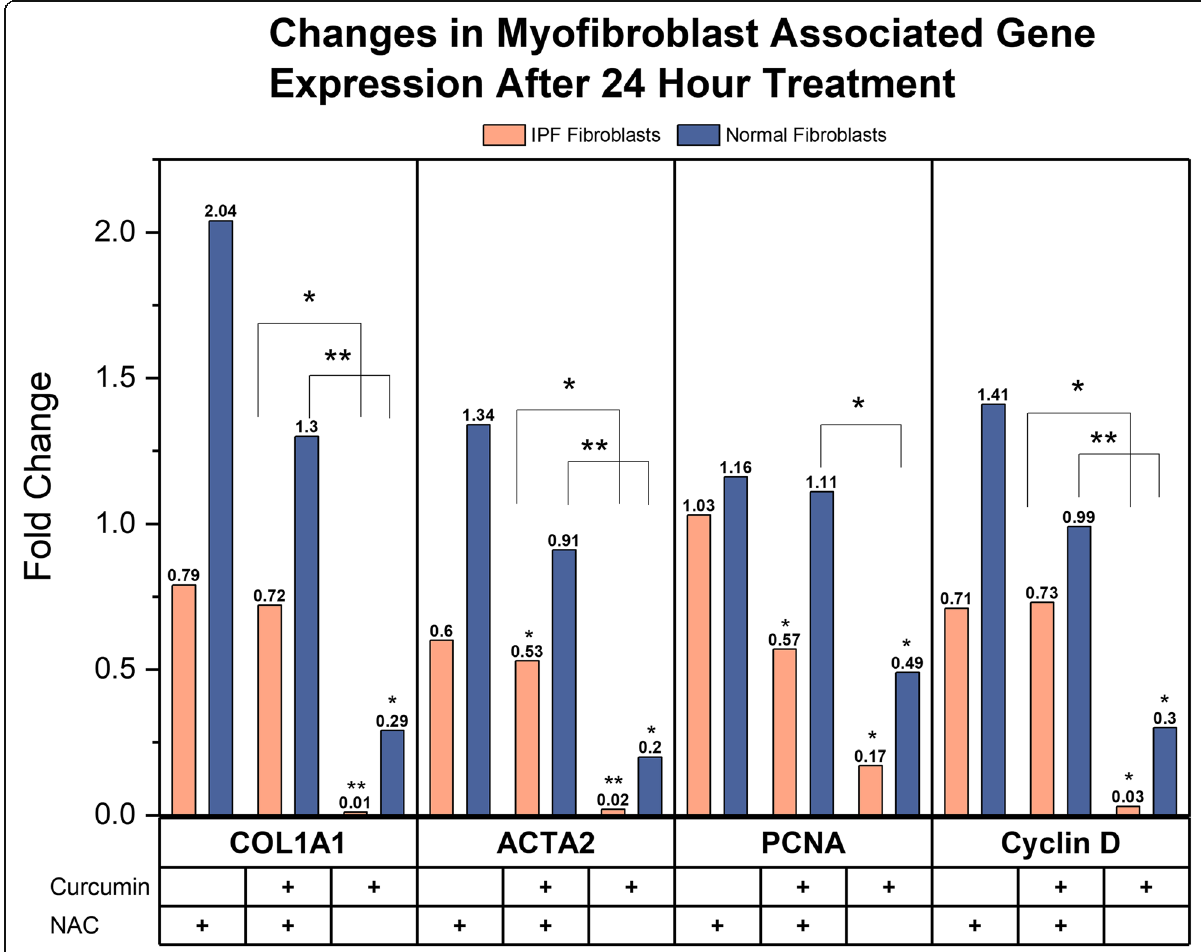
Fig. 2 Effects of 24-h 10 mM NAC challenge and 24-h combination 40 μ M curcumin/10mM NAC challenge on myofibroblast associated gene expression in fibroblasts: 10 mM NAC alone or co-treatment with 40 μ M curcumin and 10 mM NAC does not induce significant changes to